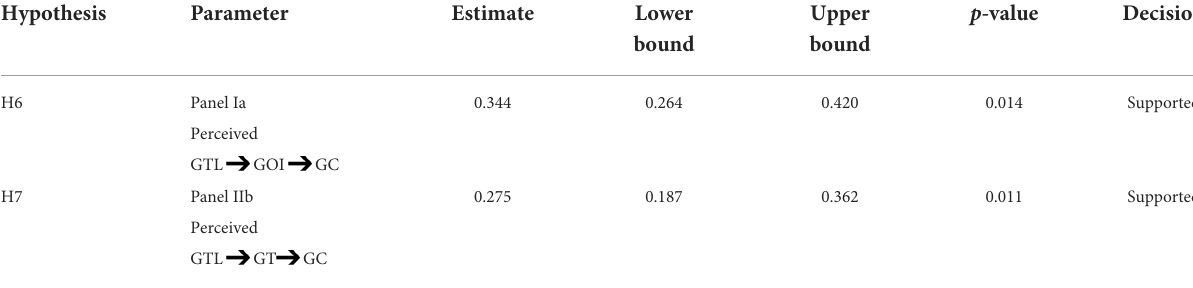
TABLE 6 Standardized mediation effects: parameter estimate and bootstrap percentile method confidence intervals.